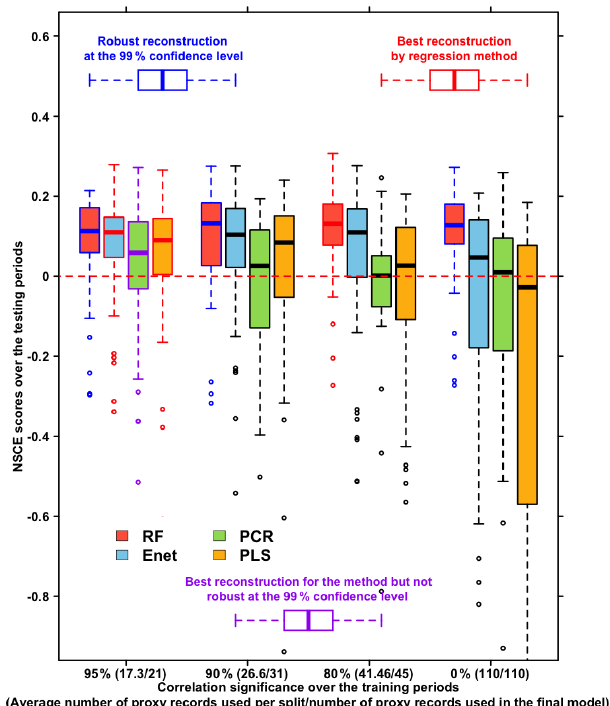
Figure 5. Boxplot of NSCE scores obtained for the four methods and different groups of proxy records by reconstructing the NAO index of the period 1000–1970 with R = 50 training/testing sam- ples. Green boxplots are the NSCE scores obtained for the PCR method. Yellow boxplots are the NSCE scores obtained for the PLS method. Red boxplots are the NSCE scores obtained for the RF method. Blue boxplots are the NSCE scores obtained for the Enet method. The first cluster of boxplots is the NSCE scores obtained by using all the available proxy records over the period (110 proxy records). The second cluster of boxplots is the NSCE scores ob- tained by using only proxy records significantly correlated with the NAO index at the 80% confidence level over the training periods. The third cluster of boxplots is the NSCE scores obtained by us- ing only proxy records significantly correlated with the NAO index at the 90% confidence level over the training periods. The fourth cluster of boxplots is the NSCE scores obtained by using only proxy records significantly correlated with the NAO index at the 95% con- fidence level over the training periods. Boxplots with blue edges are the scores significantly positive at the 99% confidence level. Box- plots with red edges correspond to the scores associated with the best reconstruction for each